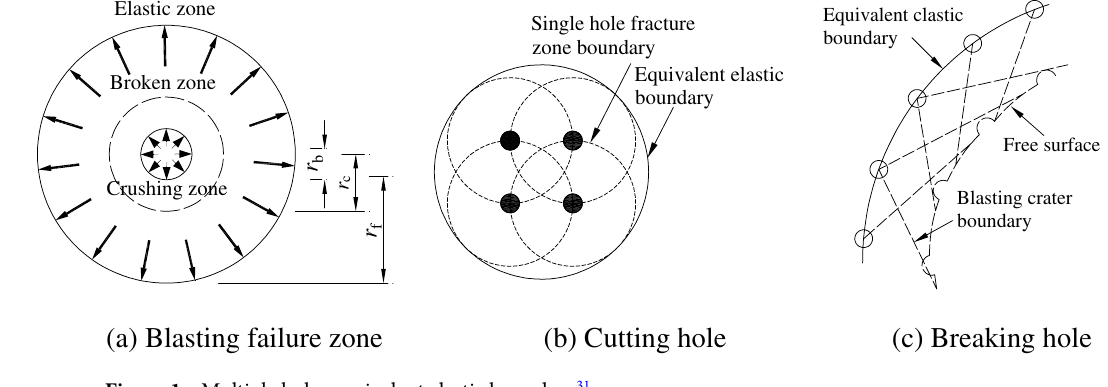
Figure 1. Multiple holes equivalent elastic boundary 31